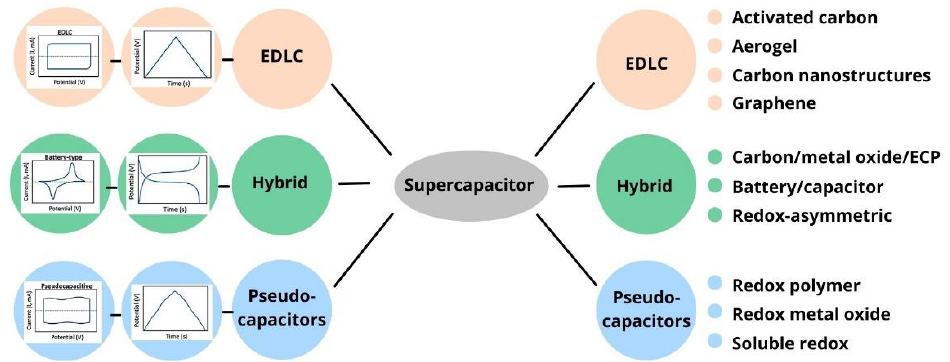
Figure 1. Different classes and subclasses of supercapacitors based on the electrode